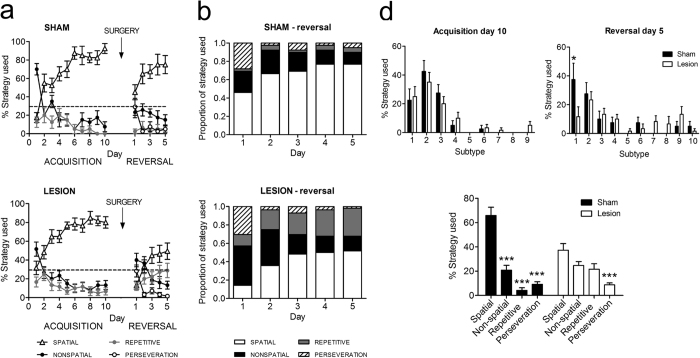
QA-induced mPFC damage affects the use of cognitively demanding spatial search strategies.(a) Both sham (upper panel) and QA-injected animals (bottom panel) adopted a prominent use of spatial strategies during the acquisition phase of MWM learning (i.e., before the surgical procedure, white triangles). After surgery, sham mice quickly return to their use of spatial strategies (non-spatial and repetitive strategies as well as perseveration occur well below chance level). In contrast, QA-injected animals never regain their use of spatial strategies, and rather continue to rely on a mixture of other types of search strategies. Data are presented as means ± SEM. (b) Increase in the proportional use of different search strategies across 5 days of reversal learning (after surgery) in the sham-treated group. White bars illustrate the increasing use of spatial strategies, reaching a maximum on days 4 and 5. (c) Defects in spatial strategy use in QA-injected animals. These mice reached their maximal, more limited use of spatial strategies already on day 3, and continued to rely substantially on repetitive strategies. (d) Marked differences in the use of strategy subtypes between control and lesioned mice on the last reversal day. The figure compares between their last day of acquisition (upper left) and reversal (upper right). Number in the x axis corresponds to the different strategy subtypes as listed in Table 2 with (1) spatial direct; (2) spatial indirect; (3) focal correct; (4) scanning; (5) random; (6) focal incorrect; (7) chaining; (8) peripheral looping; (9) circling; (10) perseveration, only possible on reversal days. The bottom panel shows that sham animals almost exclusively used spatial strategies (spatial v. non-spatial: p < 0.001; spatial v. repetitive: p < 0.001; spatial v. perseveration: p < 0.001), whereas lesioned animals do not have a preference for any particular search strategy. However, perseveration was very low in both groups (spatial v. perseveration: p < 0.001).